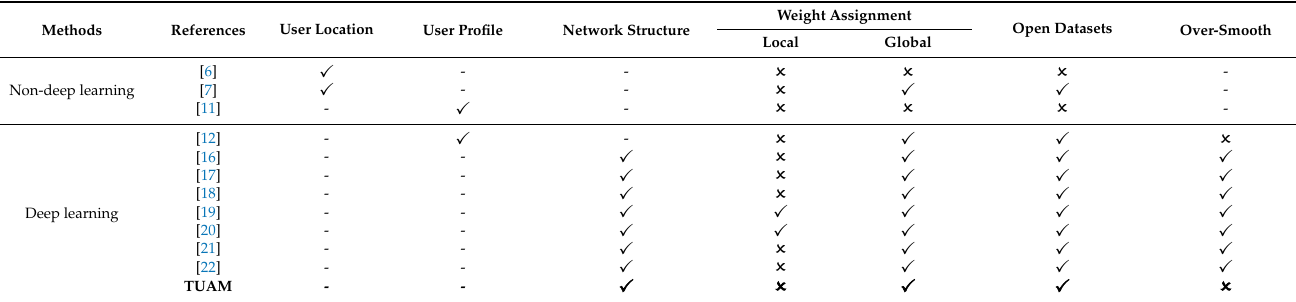
Table 1. The comparisons of the existing user alignment models.